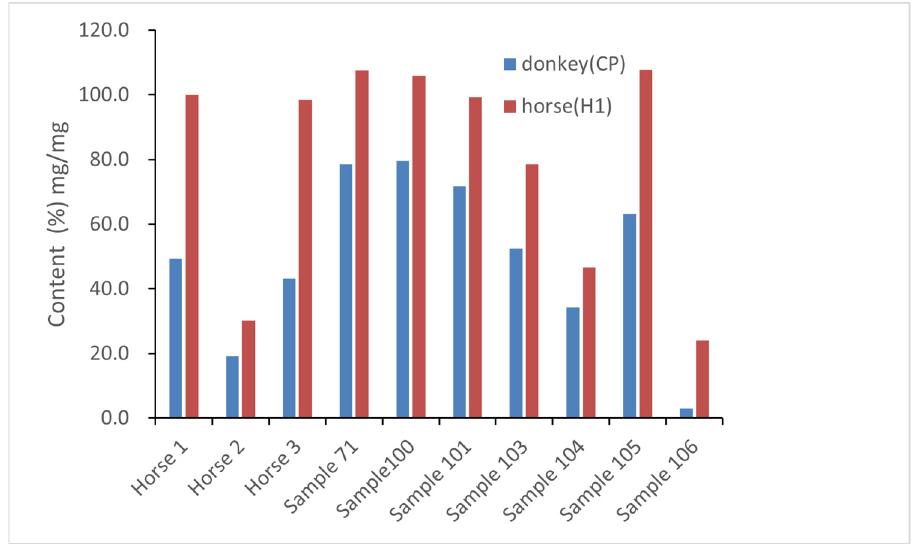
Figure 6. Comparison of relative content of donkey marker in the Chinese Pharmacopoeia ( blue ) and horse-specific marker 1 ( red ) in pure horse-hide gelatins. Horse 1, 2, and 3 are homemade horse-hide gelatins; other samples are commercial Ejiao samples mentioned above.